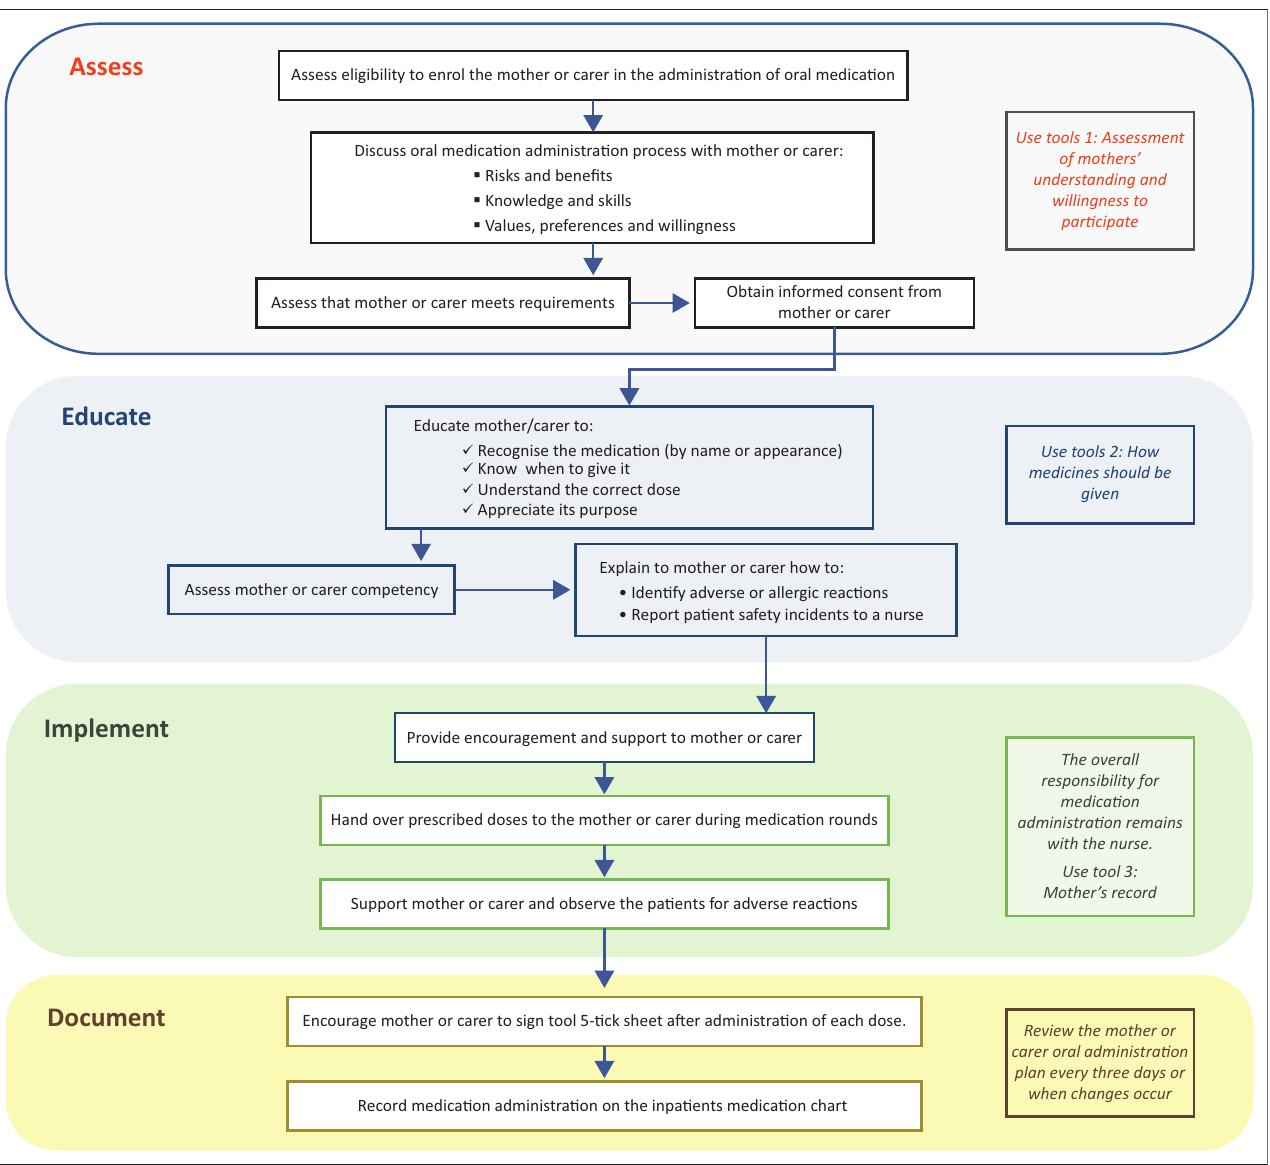
FIGURE 2: Flowchart summary to guide nursing